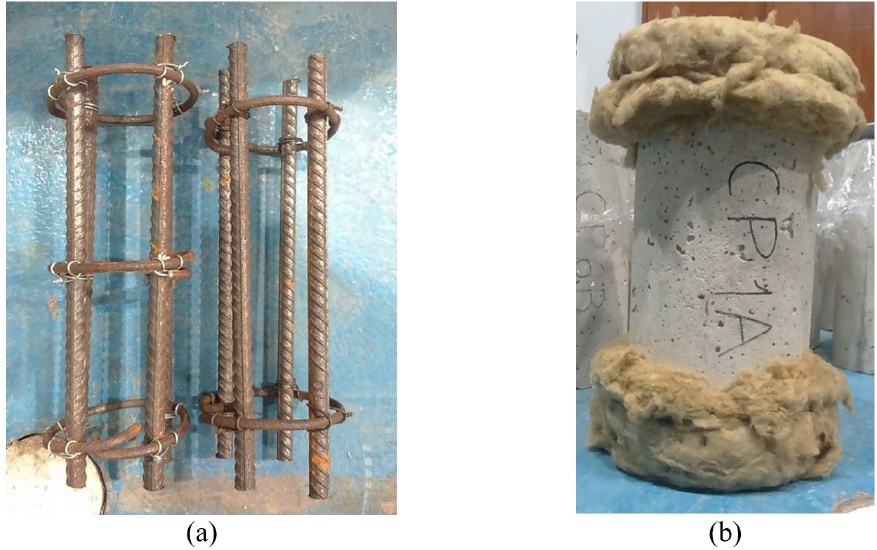
Figure 2. Preparation of Stage II specimens: a) reinforcement configuration with two and three ties; b) stone wool thermal insulation applied at the